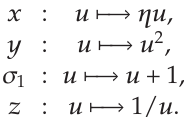
Table 4: The projective plane P